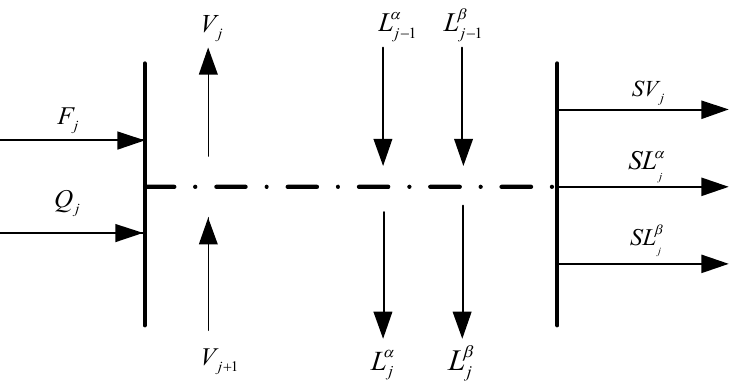
Figure 3. Three-phase balance model of the vapor–liquid–liquid rectification tray structure.